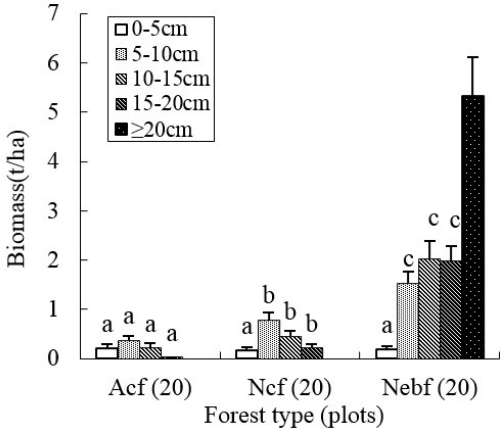
Figure 2. Biomass of fallen trees for different diameter classes in artificial and natural forests. Different lowercase letters indicate significant differences between different forest types ( Acf , Ncf or Nebf ) of the same diameter class ( p < 0.05). Table 3. Biomass of fallen trees by diameter class for different stand and forest types.